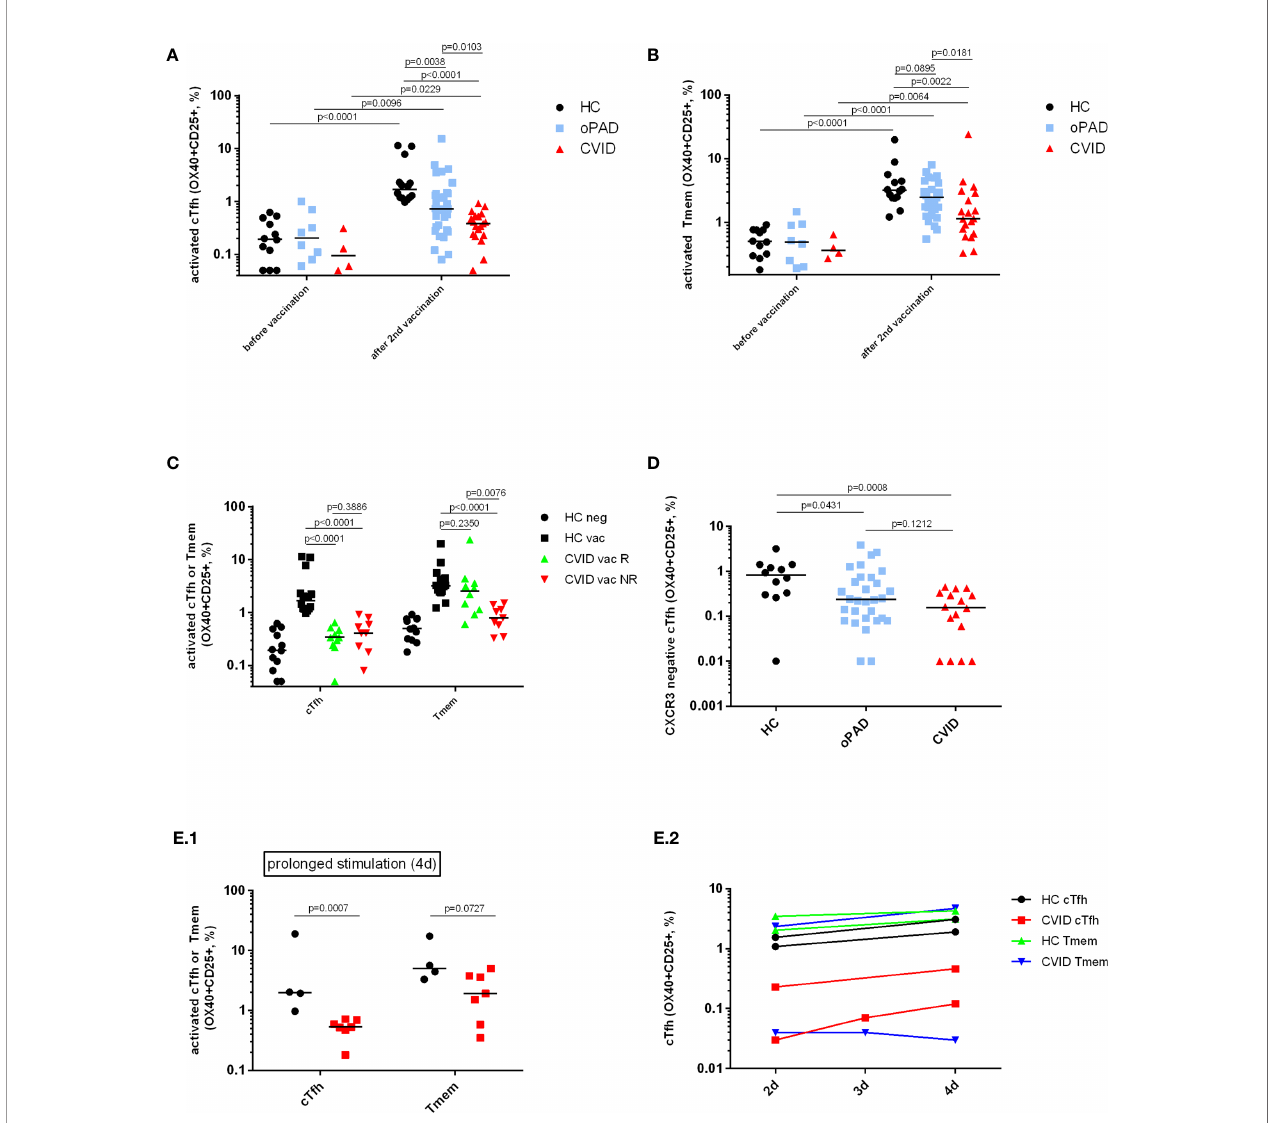
FIGURE 3 | Detection of SARS-CoV-2 spike protein-speci fi c CXCR5 + circulating follicular T-helper cells (cTfh), CXCR3-negative cTfh and CXCR5 − CD4 + T-memory cells (Tmem) by fl ow cytometry. Human peripheral blood mononuclear cells (PBMC) from healthy controls (HC), CVID patients and patients with other, milder forms of primary antibody de fi ciency (oPAD), before COVID-19 vaccination and after the second vaccination with BNT162b2, were stimulated for two days using overlapping peptides of immunogenic regions of SARS-CoV2 spike protein (1 µg of peptides/ml). Activation of circulating follicular T-helper cells [CD3 + CD4 + CD45RA - CXCR5 + , cTfh, panel (A) ] and CXCR5-negative CD4 memory T cells [Tmem, panel (B) ] was determined by measuring upregulation of CD25 and CD134 (OX40) by fl ow cytometry. Results are expressed as percent CD134 (OX40) and CD25 double positive cells relative to the respective CD4 + T cell subpopulation. Unstimulated control cells were incubated in parallel in culture medium only (percent CD134 and CD25 double positive unstimulated cells, median [IQR], before vaccination: HC (n = 12), Tfh 0.04 [0.04], Tmem 0.11 [0.42]; CVID (n = 4), Tfh 0.06 [0.15], Tmem 0.1 [0.2]; oPAD (n = 8), Tfh 0.06 [0.13], Tmem 0.05 [0.01]; after the second vaccination: HC (n = 14), Tfh 0.13 [0.11], Tmem 0.11 [0.42]; CVID (n = 19), Tfh: 0.03 [0.11], Tmem 0.08 [0.14]; oPAD (n = 31), Tfh 0.08 [0.11], Tmem 0.07 [0.53]; Kruskal – Wallis H test: n.s.). Panel (C) shows percent of activated, CD134 (OX40) and CD25 double positive cTfh following stimulation of PBMC for two days using overlapping peptides of immunogenic regions of SARS-CoV2 spike protein (1 µg of peptides/ml). PBMC were obtained from healthy controls (HC), CVID responders (anti-spike protein IgG antibody following second vaccination > three times cutoff = 33 RE/ml) and CVID non-responders after the second vaccination against COVID-19. Panel (D) shows the percentage of activated CD134 (OX40) and CD25 double positive CXCR3-negative cTfh activated in response to stimulation with SARS-CoV-2 spike peptides. Panel (E) shows activation of cTfh and Tmem as assessed by measuring OX40- and CD25-expression following prolonged stimulation with SARS-CoV-2 spike peptides for 4 days [panel (E.1) ; black circles: healthy controls, red squares:CVID]. In two healthy controls and two CVID patients, cTfh and Tmem activation was examined after two, three and four days of stimulation with SARS-CoV-2 spike peptides [panel (E.2) ]. Statistical differences between two groups are depicted in the fi gure and were determined with a non-parametric two-tailed Mann – Whitney U-test (Kruskal – Wallis H test for all groups: p <0.0001), the median is represented by a horizontal